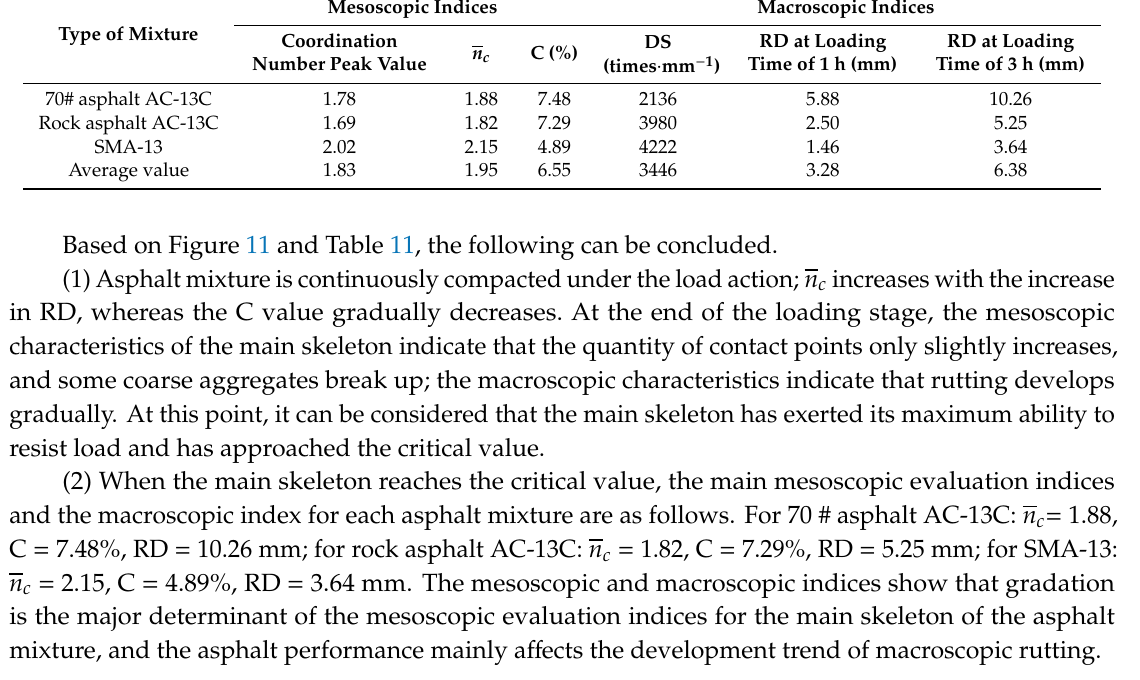
Table 11. Corresponding mesoscopic and macroscopic indices when main skeleton reaches critical value. Type of